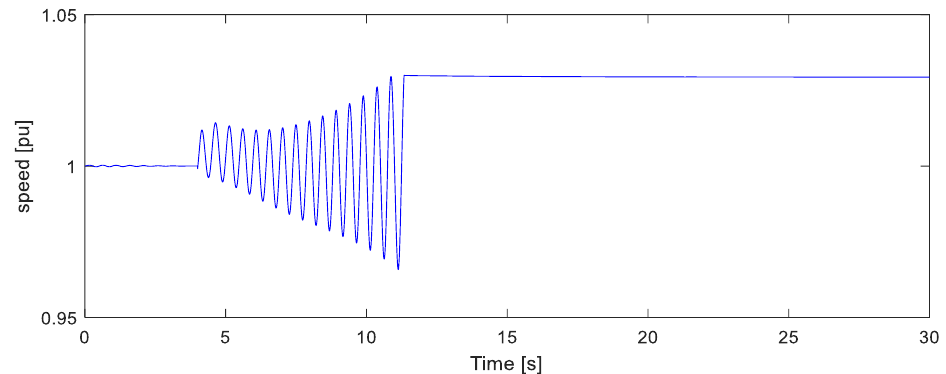
Figure 17. Short-circuit frequency response and RoCoF for the worst cases of the reference, future and future with BESS scenarios.